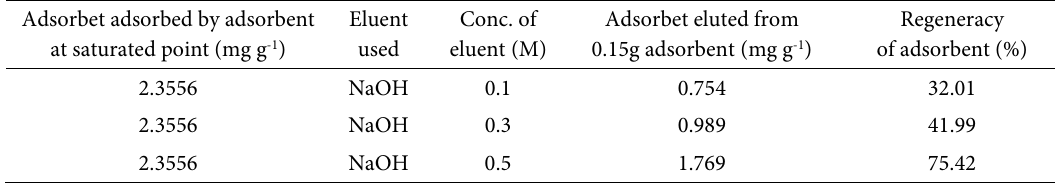
Table 1. Desorption study of TiOSA